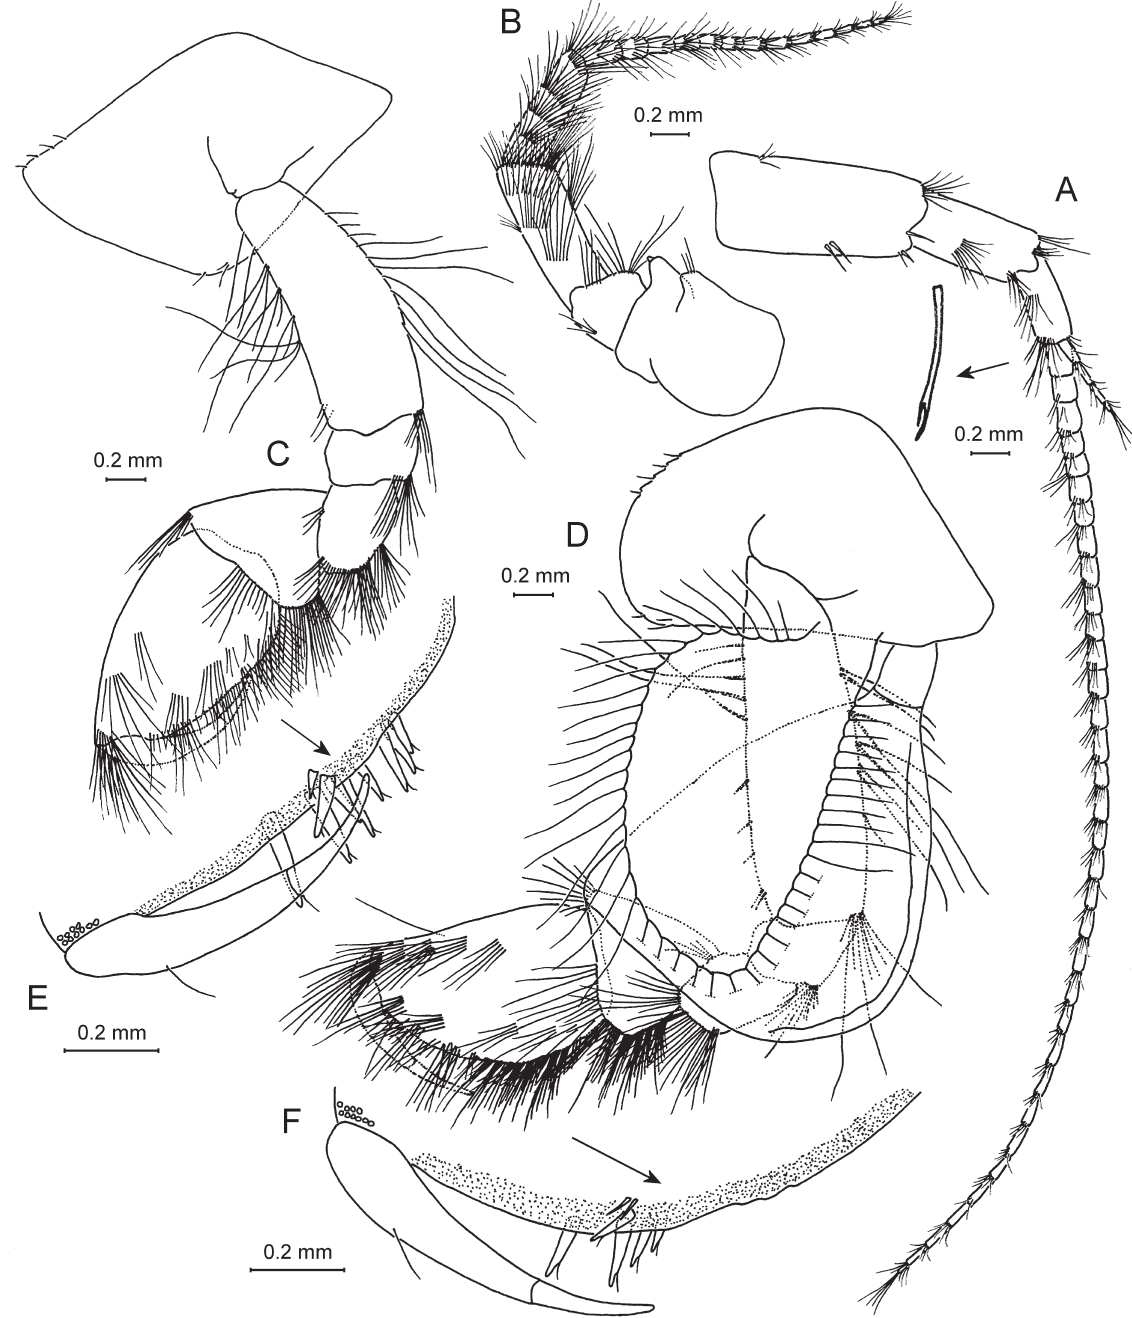
Fig. 12. Adaugammarus pilosus gen. et sp. nov. Holotype, ♀, 13.5 mm, X44046/Cr-1652-FEFU. A . Antenna 1. B . Antenna 2. C . Gnathopod 1. D . Gnathopod 2. E–F . Palmar margins of gnathopods 1 and 2 propodi (setation